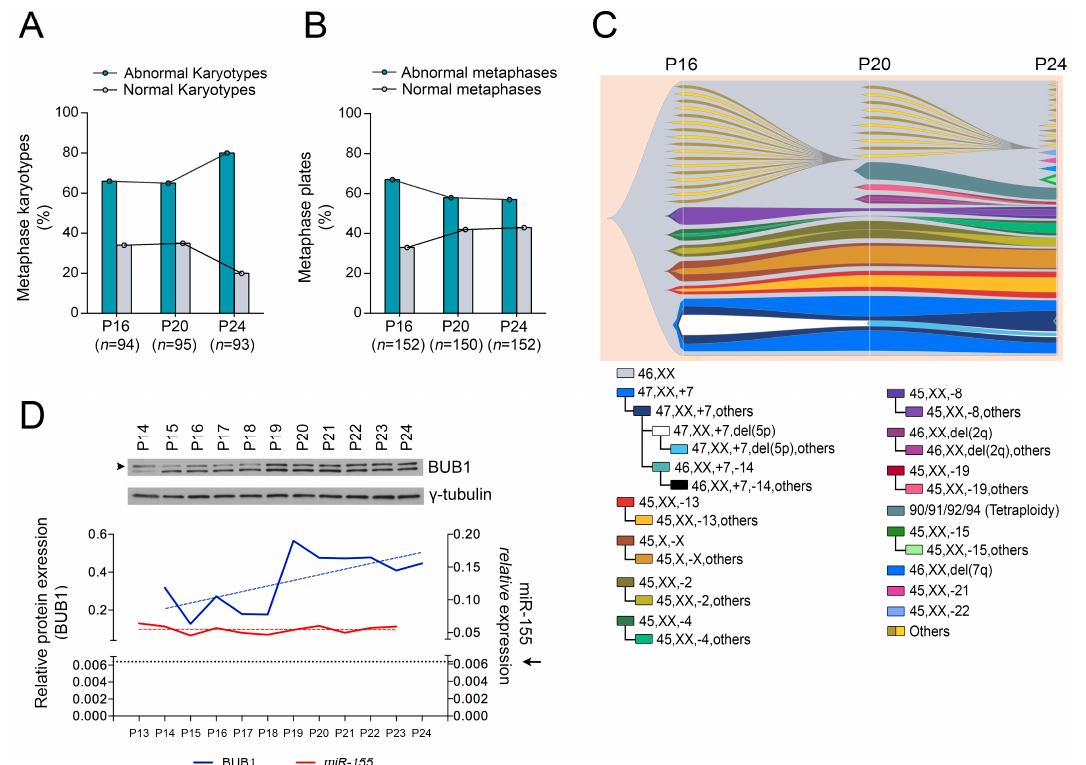
Figure 1. Expansion of most adaptive clones with normal metaphase plates is associated with increase of BUB1 expression in the advance passages of HDF LT / hTERT cells. ( A ) Karyotype analysis and ( B ) metaphase analysis of HDF LT / hTERT cells at P16, P20 and P24 passages. For karyotype analyses, HDF LT / hTERT cells were arrested in mitosis by colcemid treatment (0.5 µ g / mL for 4 h). A minimum of 93 metaphases was considered in each experiment. For immunofluorescence, the cells were arrested in mitosis by nocodazole (75 ng / mL) for 17 h, plus 30 min of release; > 150 metaphases were considered for each experiment. We considered abnormal those metaphases that showed errors in chromosomes congression with distinct defects of the kinetochore alignment respect to the metaphase plate. The percentages calculated are the result of eight technical replicates. ( C ) Visualization of the karyotype analysis of HDF LT / hTERT cell at P16, P20 and P24 passages with the fishplot package R. Each color represents a di ff erent karyotype identified at least twice in the metaphases analyzed (i.e., “46, XX”, normal karyotype; “47, XX, + 7”, duplication of chromosome 7; “47, XX, + 7, others”, duplication of chromosome 7 with others chromosome aberrations, etc.). Karyotype identified once were called “other karyotypes” and were represented in grey and light yellow. ( D ) Upper, Western blot analysis of BUB1 protein (120 kDa, blue line, P14-P24) and miR-155 expression (red line, P13-P23) during the immortalization passages of HDF LT / hTERT cells. Linear regression of miR-155 (red dotted line) and of BUB1 protein expressions (blue dotted lines) are represented. The dotted line marked by the black arrow represents the miR-155 expression level in normal HDF at P17. BUB1 protein levels were quantified by Western blotting using γ -tubulin as loading control.